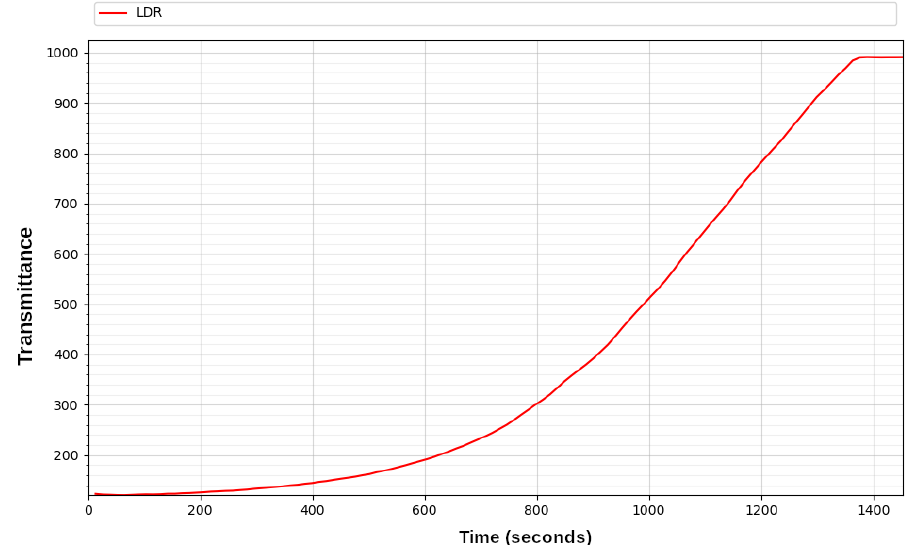
Figure 11. Transmittance plot of the degradation conducted in a photocatalytic reactor using an LDR sen-